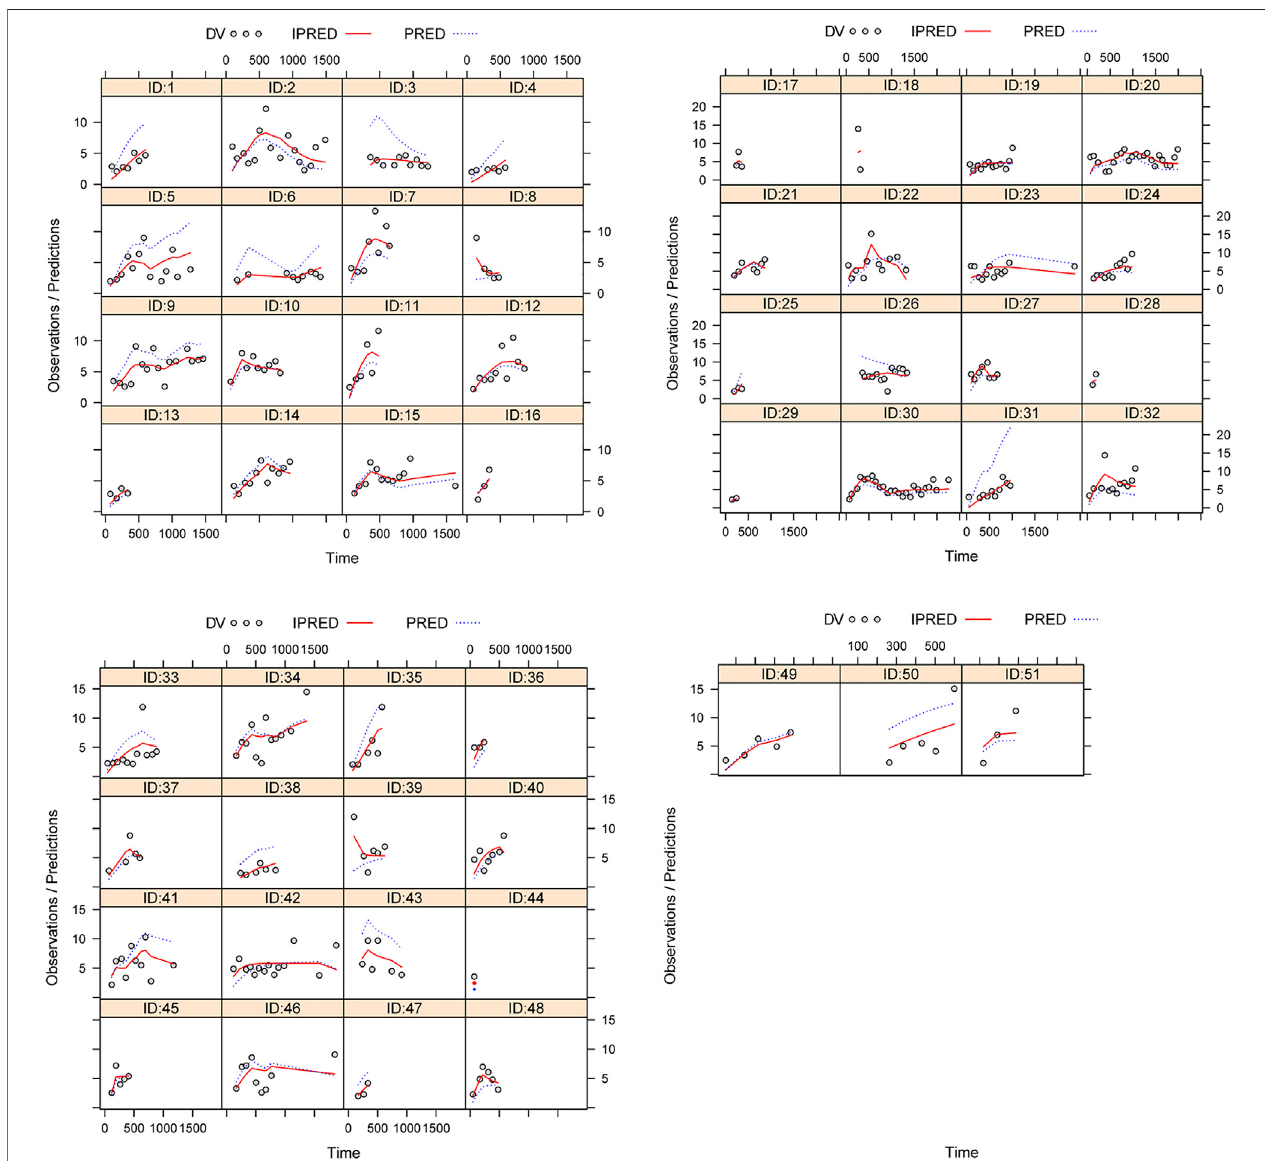
FIGURE 2 | Individual plot ID: patient ID number. DV: measured concentration value. IPRED: individual predictive value. PRED: population predictive value.